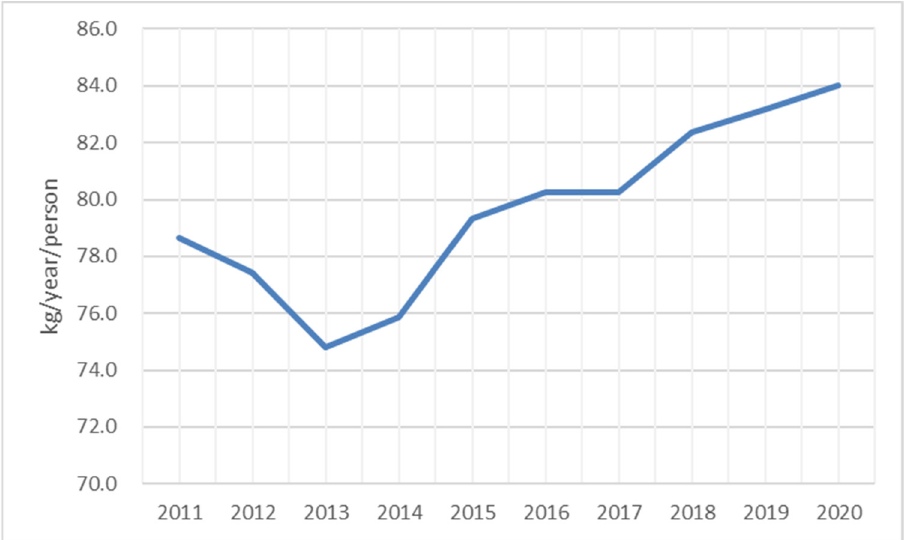
Figure 1. Meat consumption in the Czech Republic per capita [56]. Table 2. Selected ungulates in Czech Republic hunting statistics (in pieces).